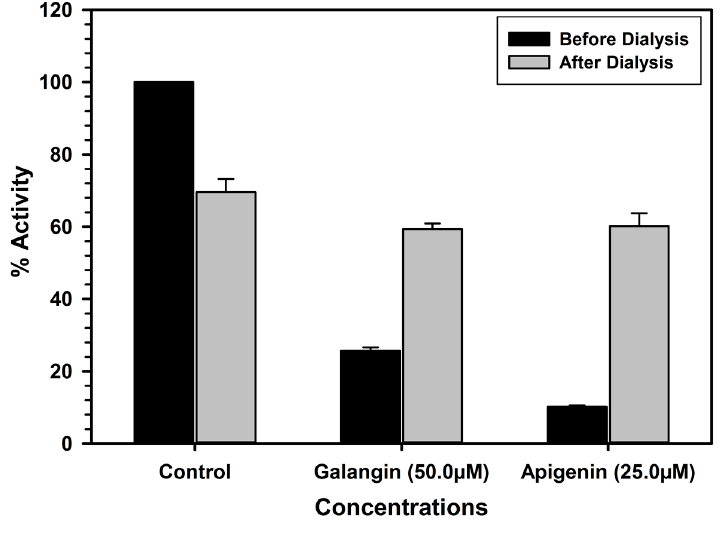
Figure 7. Analysis of nature of binding of galangin and apigenin with recombinant human MAO- B by recovery of catalytic activity of the enzyme after dialysis dissociation. Each bar shows mean ± S.D. of triplicate